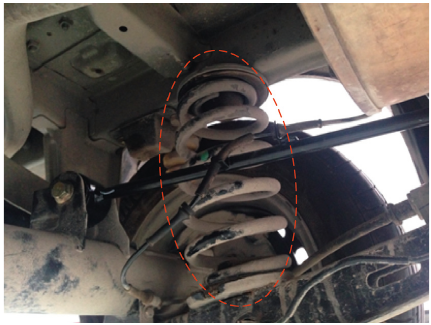
Figure 31: Suspension spring stiffness